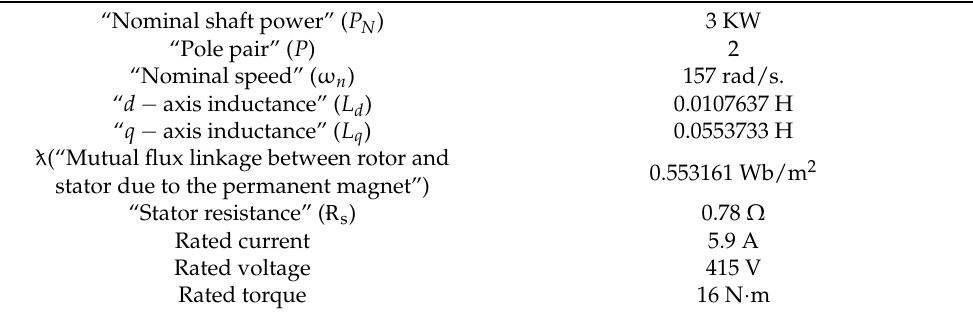
Table 1. Machine parameters. Table 1. Machine